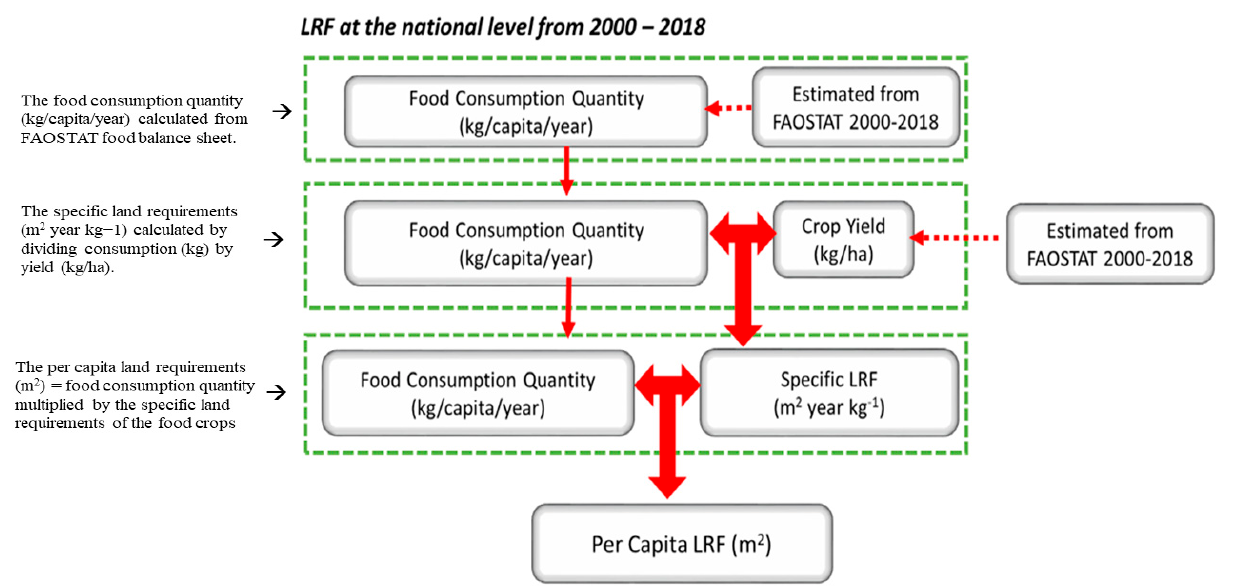
Figure 2. Diagram illustrating land requirements for food calculation at the national level. Part 2: LRF in the six geopolitical zones.